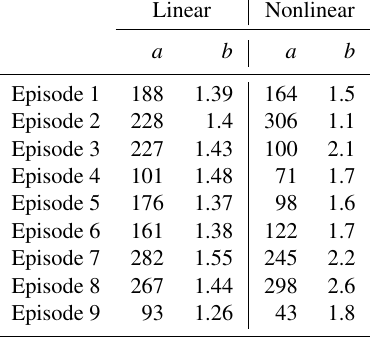
Table 2. Z – R relations derived from the 1min data of the Parsivel ® for the rainfall episodes shown in Fig. 9 using linear regression on the logarithmic values and nonlinear regression.